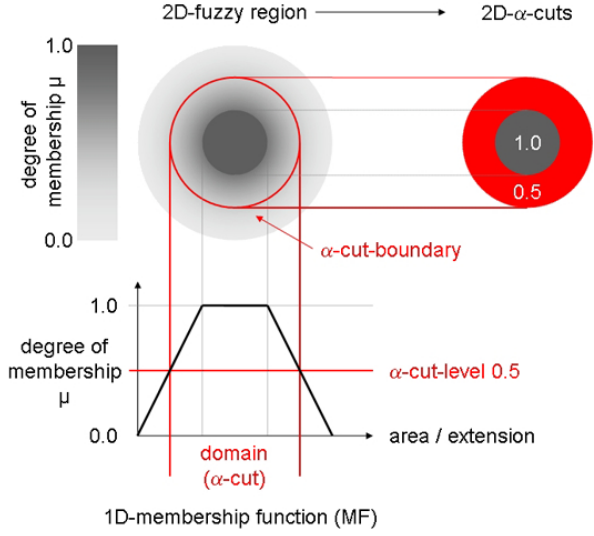
Fig. 1. Representation of a 2D- fuzzy region and its 1D-fuzzy set membership function (modified after Petry et al., 2005).